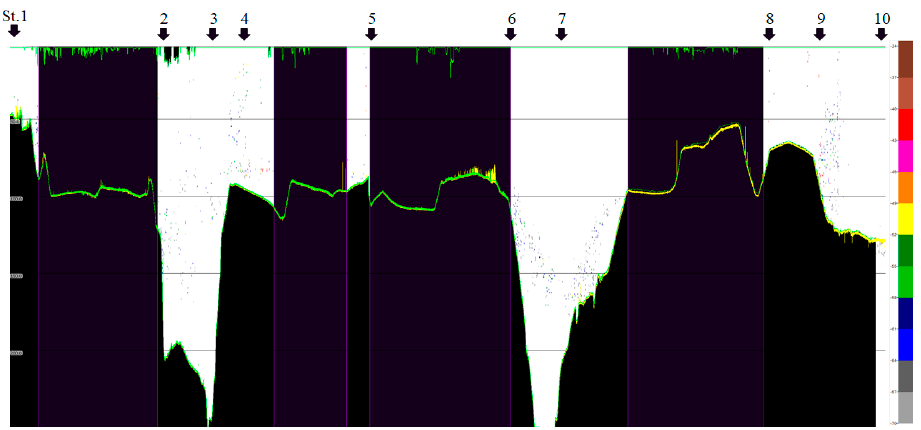
Figure 10. Vertical distribution of herring.